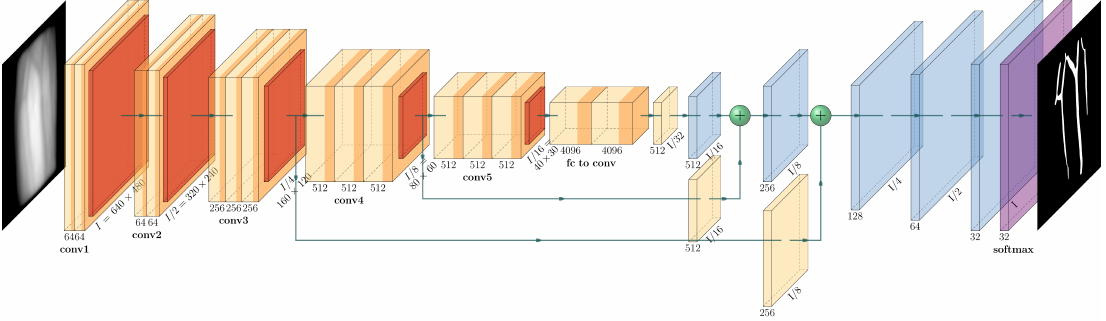
Figure 7. Fully convolutional network (FCN8) for vein segmentation. Orange layer is convolution layer, red is max-pooling, blue is upconvolution and purple is